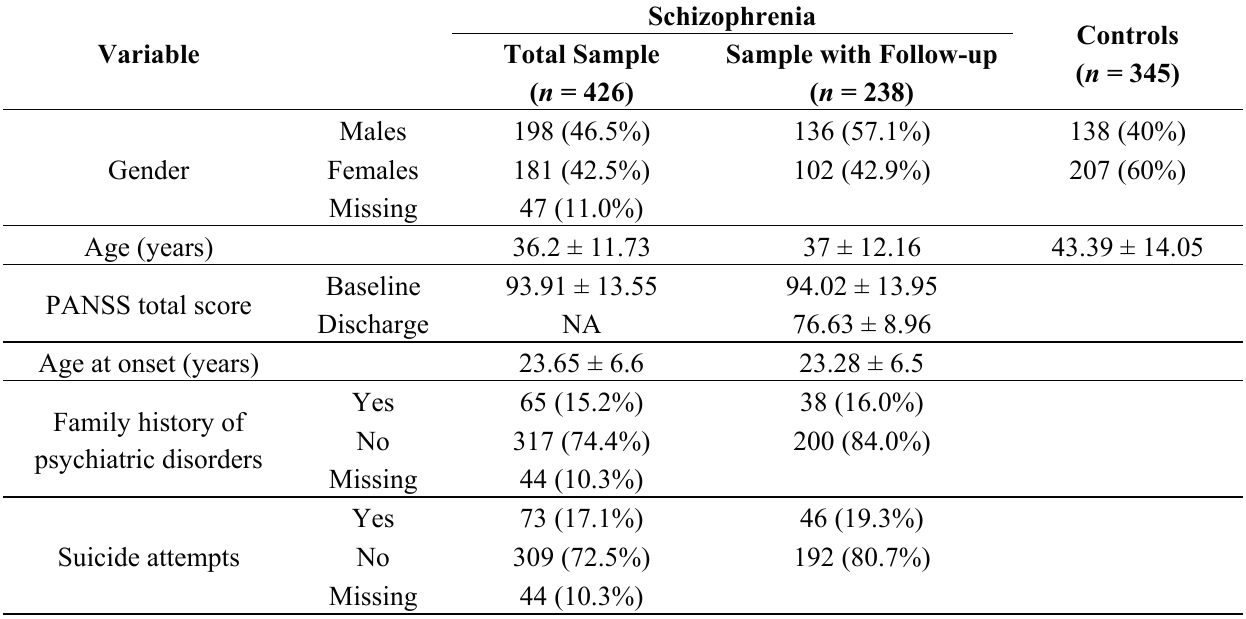
Table 1. Clinical and demographic characteristics of the sample. PANSS, Positive and Negative Syndrome